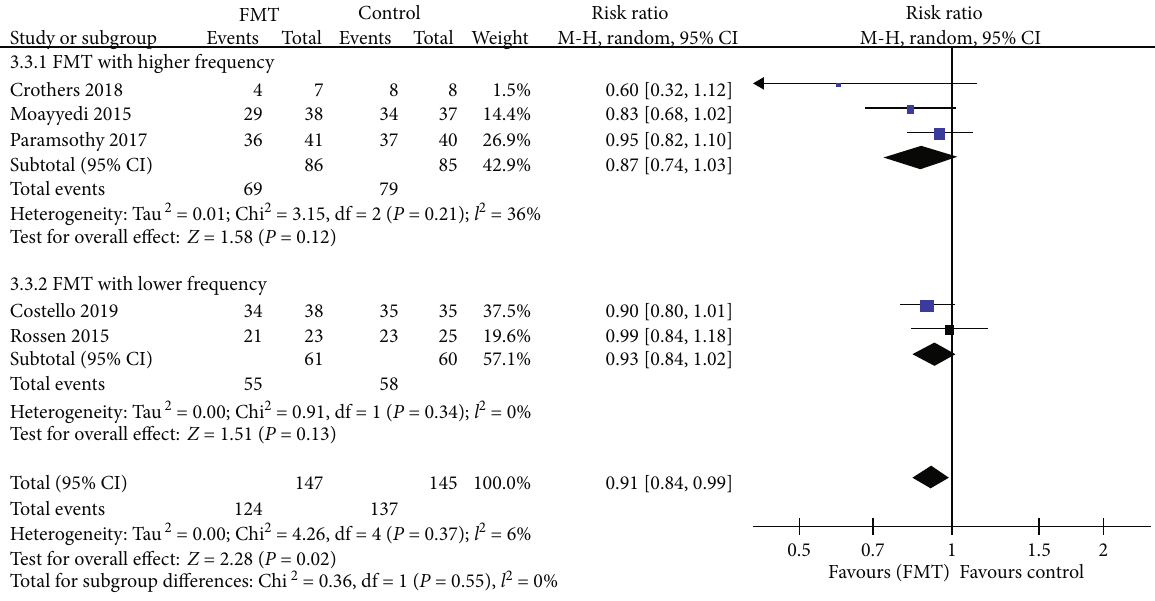
Figure 11: Forest plot of studies reporting endoscopic remission and subgroup analysis according to frequency of FMT